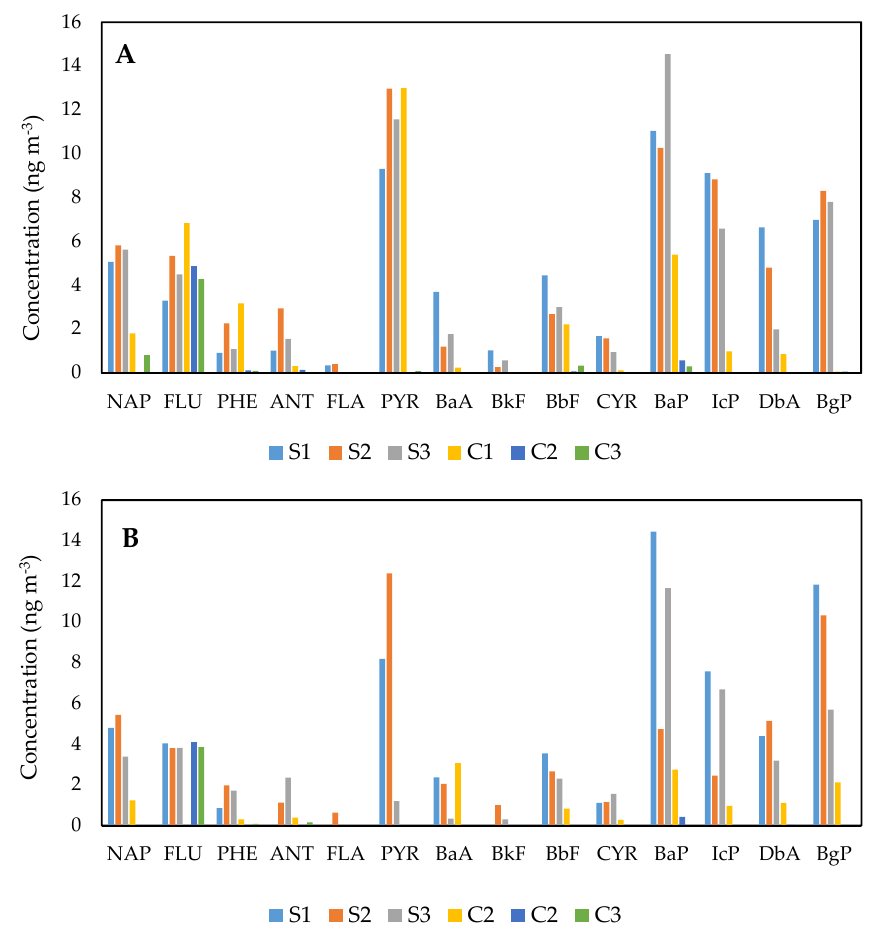
Figure 2. Distribution of polycyclic aromatic hydrocarbon (PAH) species in PM 2.5 samples (( A ): outdoor; ( B ): indoor).